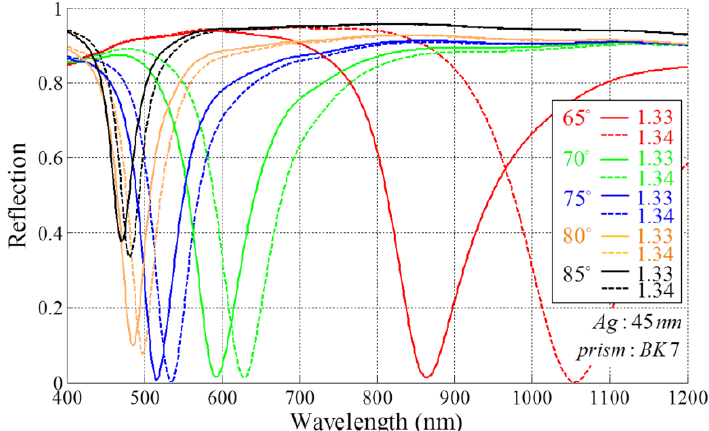
Figure 4. Reflection spectra of an SPR based sensor by varying the incident